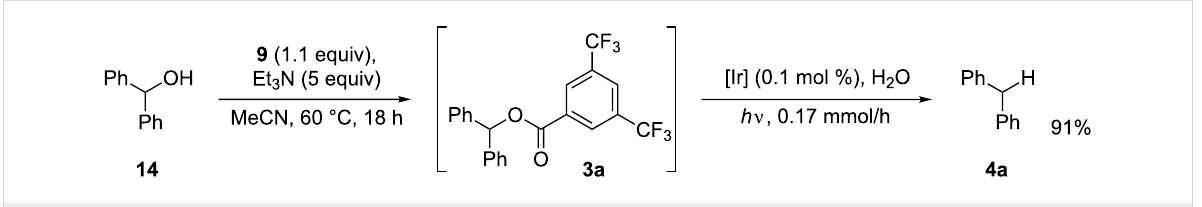
Scheme 8: Optimized conditions for larger scale